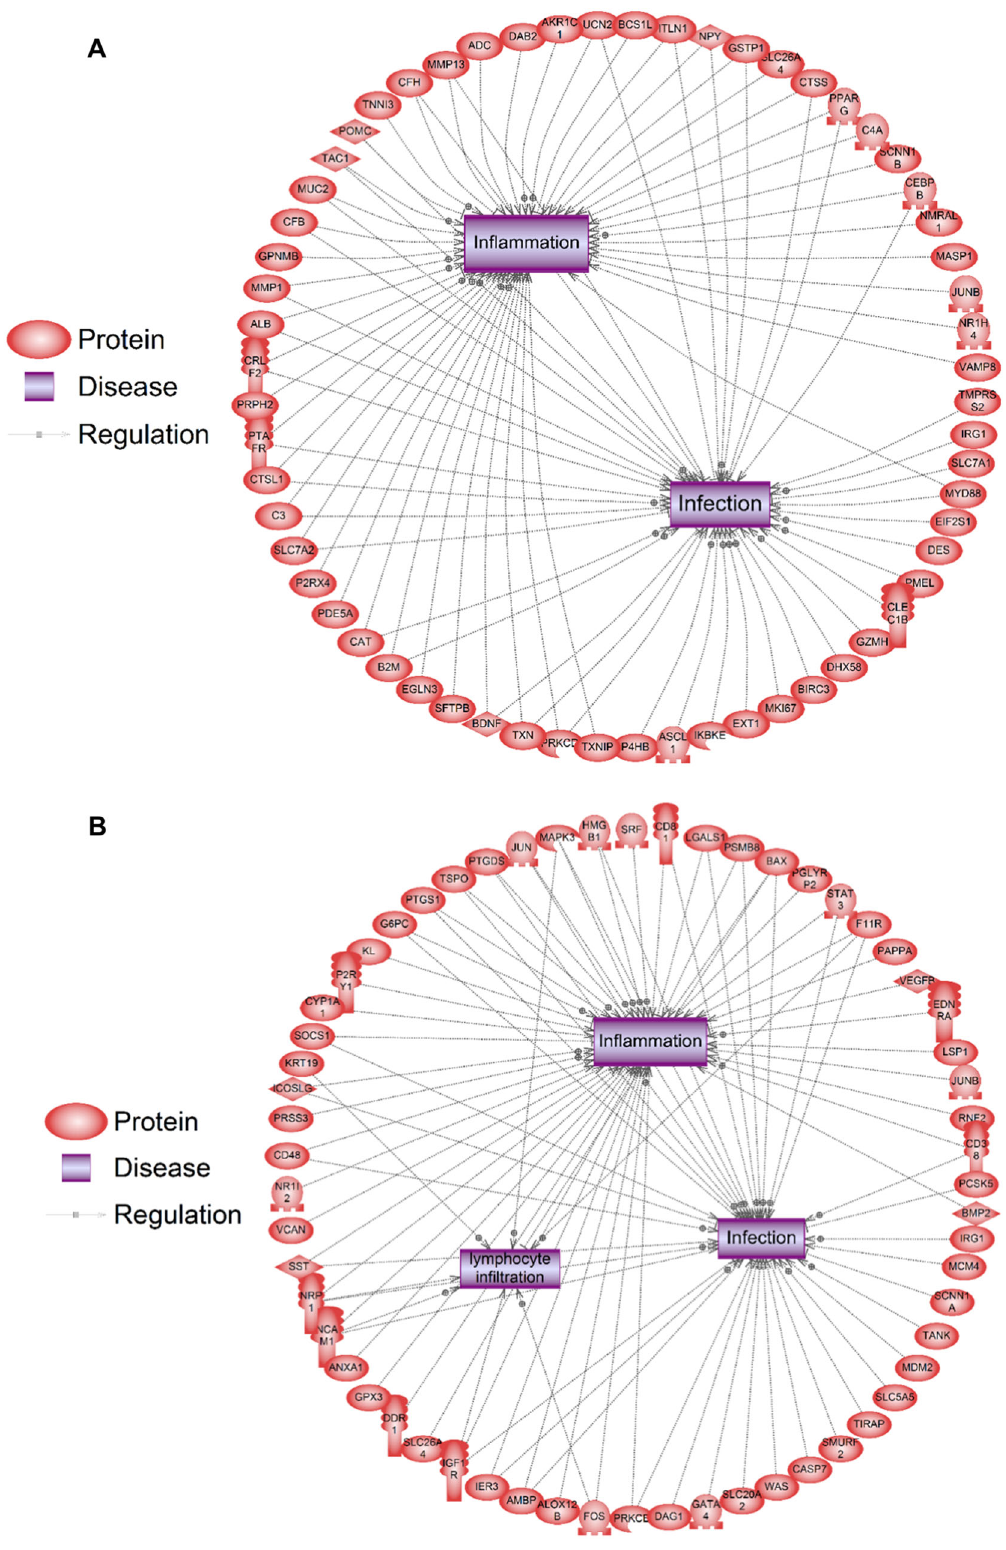
Fig. 4 Human homologs of immune genes differentially expressed at stage 45 after depolarization with ivermectin (a) or glycine receptor overexpression (b) . Proteins are red shapes , diseases are purple boxes , stimulatory regulatory events are indicated by an arrow and a plus sign on the relationship line, inhibitory regulatory events are indicated by a blunt line , and arrows without any sign indicate direct binding of